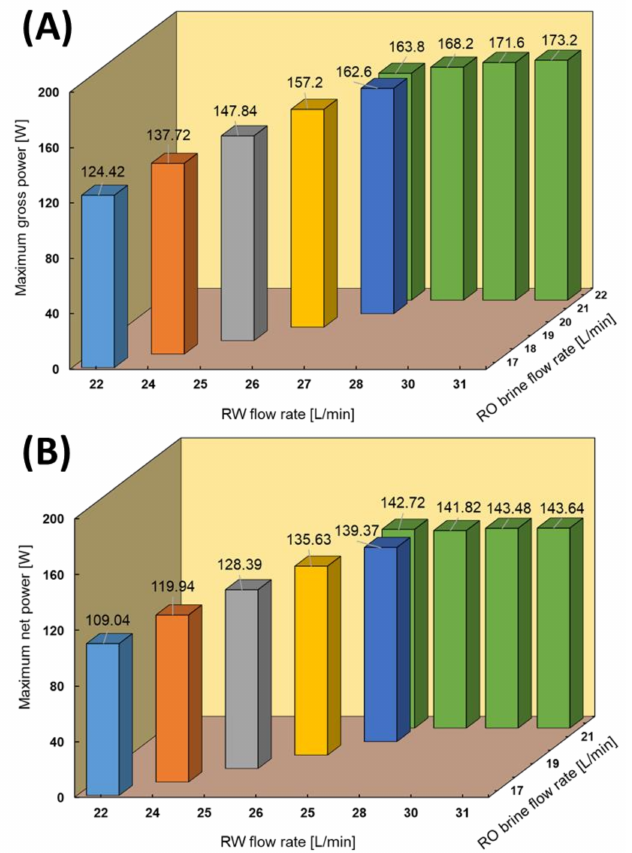
Figure 5. RED stack performance using the natural RO brine/RW feed solutions. ( A ) Maximum gross power, ( B ) Maximum net